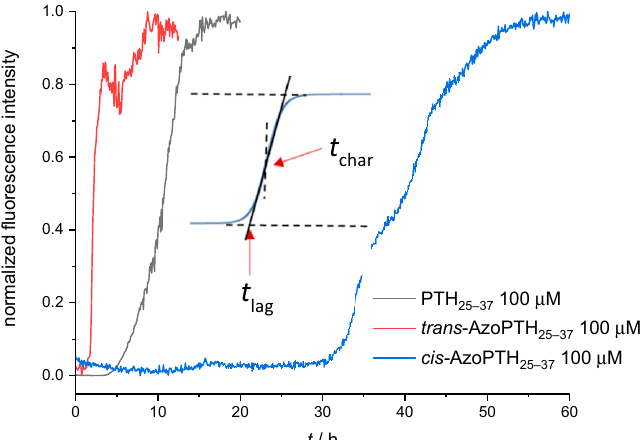
0 10 20 30 40 50